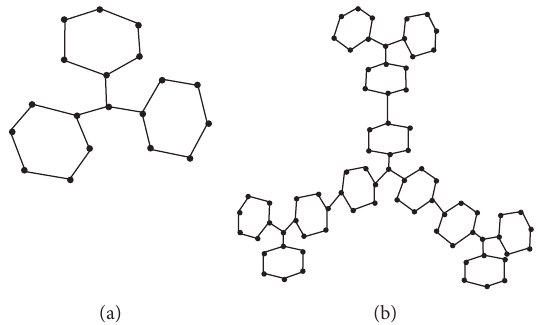
Figure 2: The nanostar dendrimer D